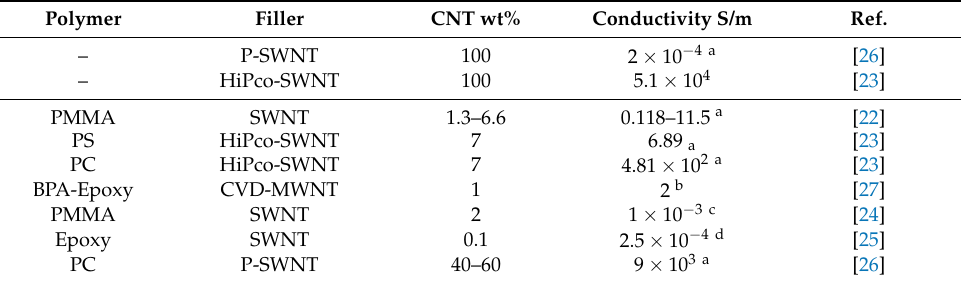
Table 1. Electrical conductivities for BP and composite BP samples from the literature. Test types are as follows: a four-point probe b two-terminal AC impedance spectroscopy c two-point probe d dielectrix